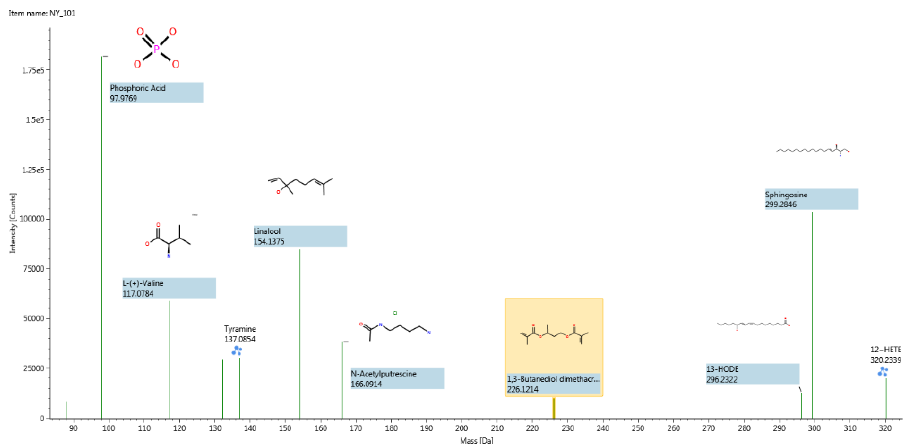
Figure 4. Structure determination of the major compounds in positive ion mode for Bactrian camels’ vaginal secretion samples.